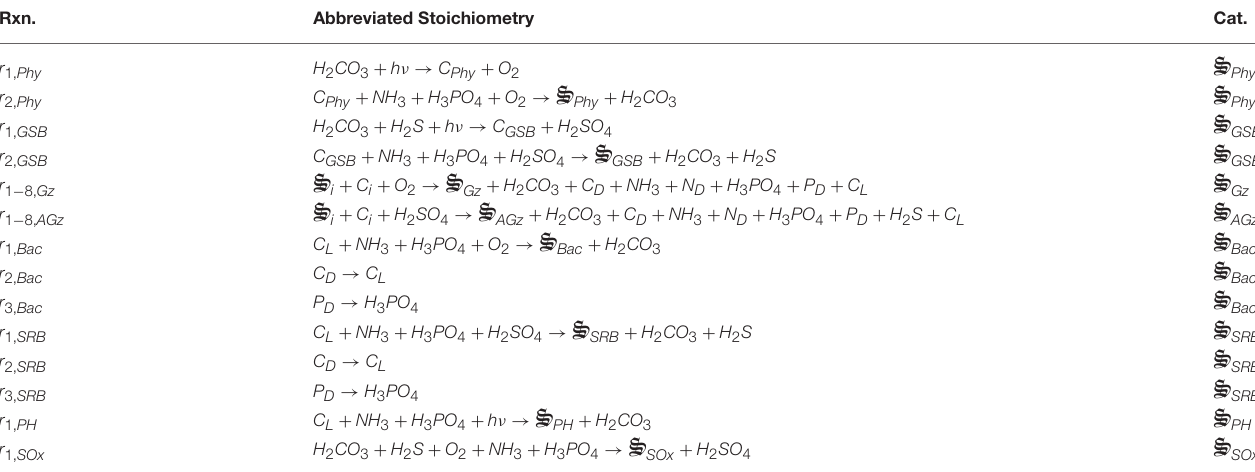
TABLE 2 | Reactions associated with the 8 biological catalysts, S j , used to model microbial biogeochemistry in Siders Pond, where r i , j represents sub-reaction i of biological catalyst S j . Rxn.